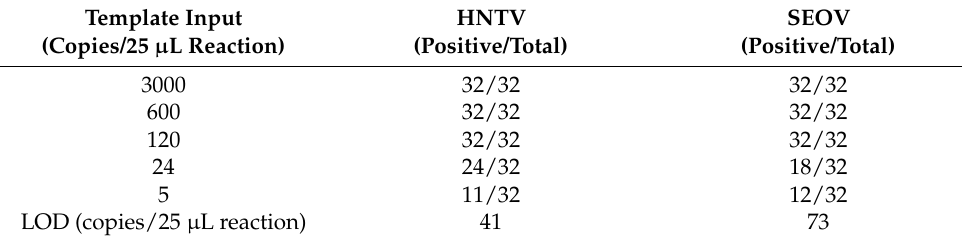
Table 2. Detection limit of RT-LAMP for HTNV and